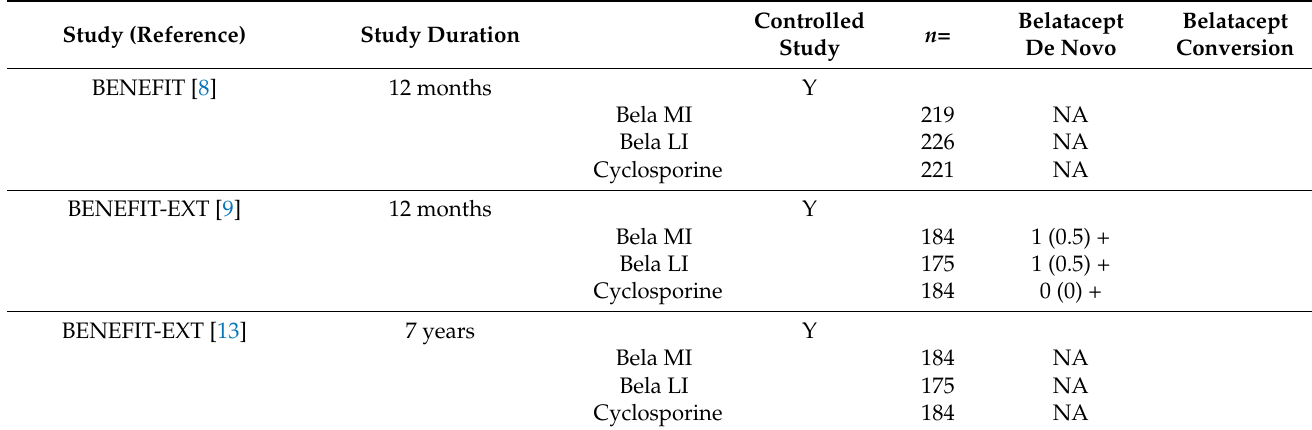
Table 2. Incidence of Pneumocystis jirovecii